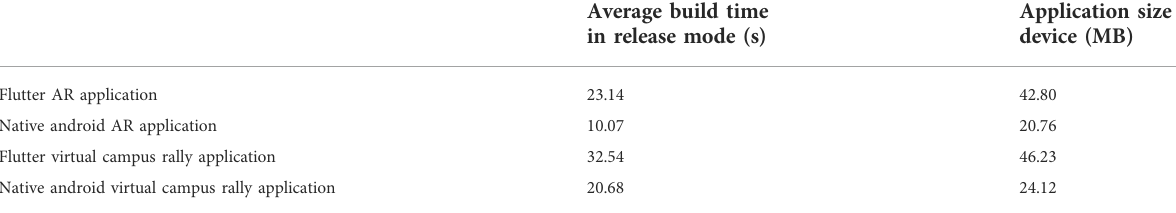
TABLE 3 Average build times and resulting application sizes of the benchmarking apps on an android